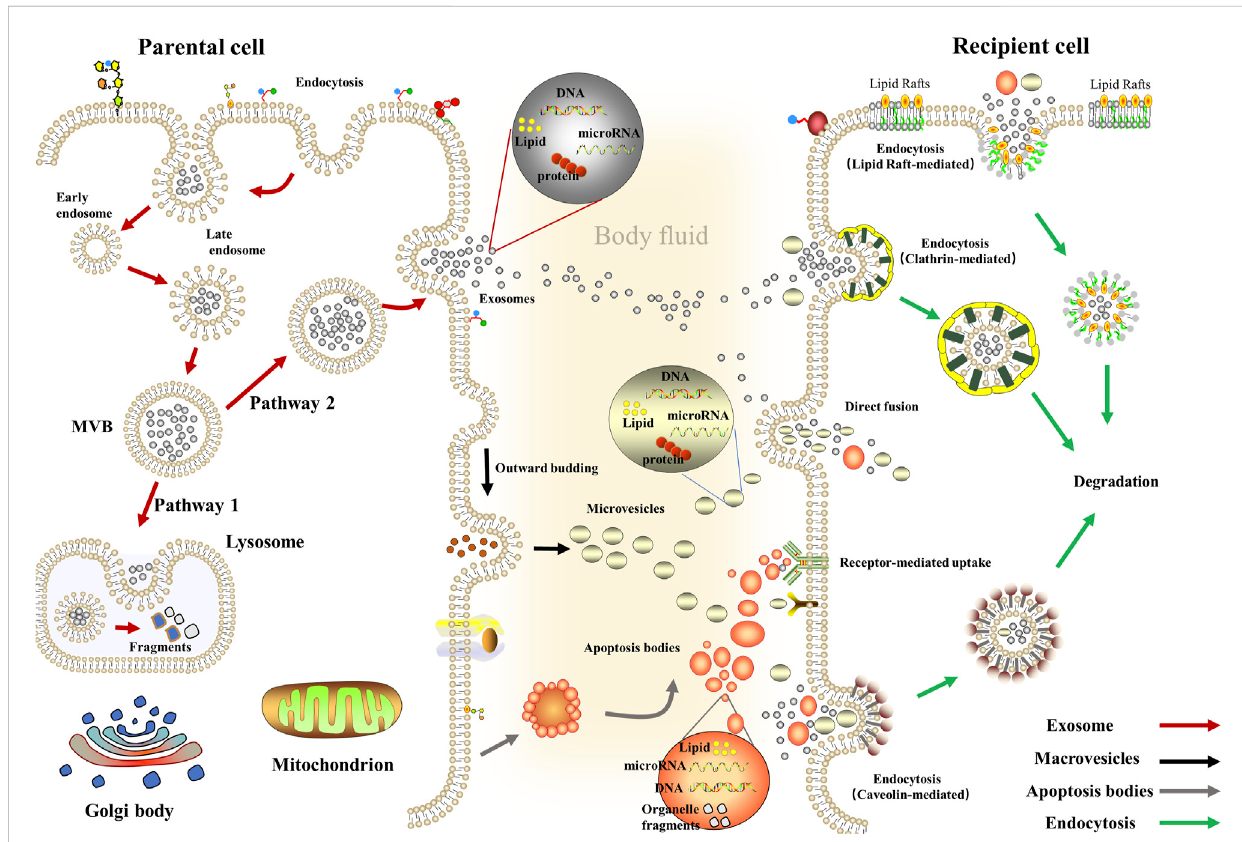
FIGURE 1 Biogenesis and delivery of extracellular vesicles. Exosomes: Inward budding of the early endosomal membrane forms early endosomes and then matures into late endosomes and evolves into MVBs. Then, some MVBs fuse with lysosomes while other MVBs fuses with the plasma membrane to release exosomes (van Niel et al., 2018); Macrovesicles: Actin-myosin interactions promote cytoskeleton contraction, aid cell membranes ’ budding, and ultimately form macrovesicles (McConnell et al., 2009); Apoptosis Bodies: The cytosolic membrane is wrinkled and invaginated, dividing and wrapping the cytoplasm, containing DNA material and organelles, forming Apoptosis Bodies (Liu J et al.,